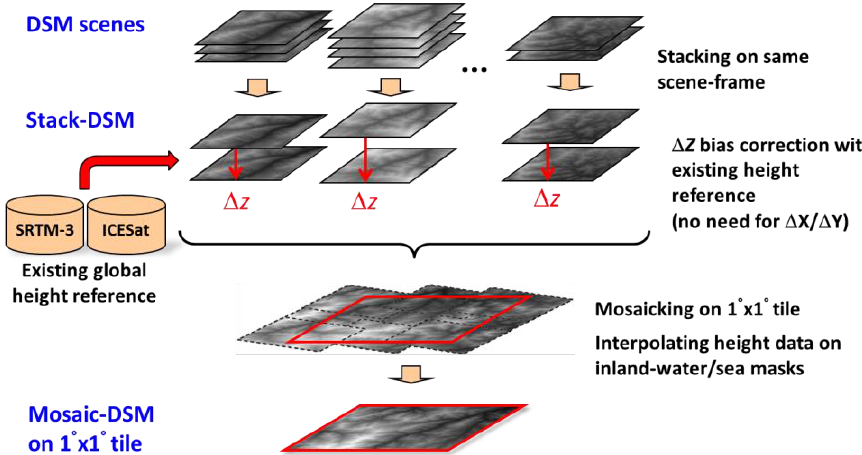
Figure 6. The concept of stacking and mosaicking processing using multi-temporal scene-based DSMs.